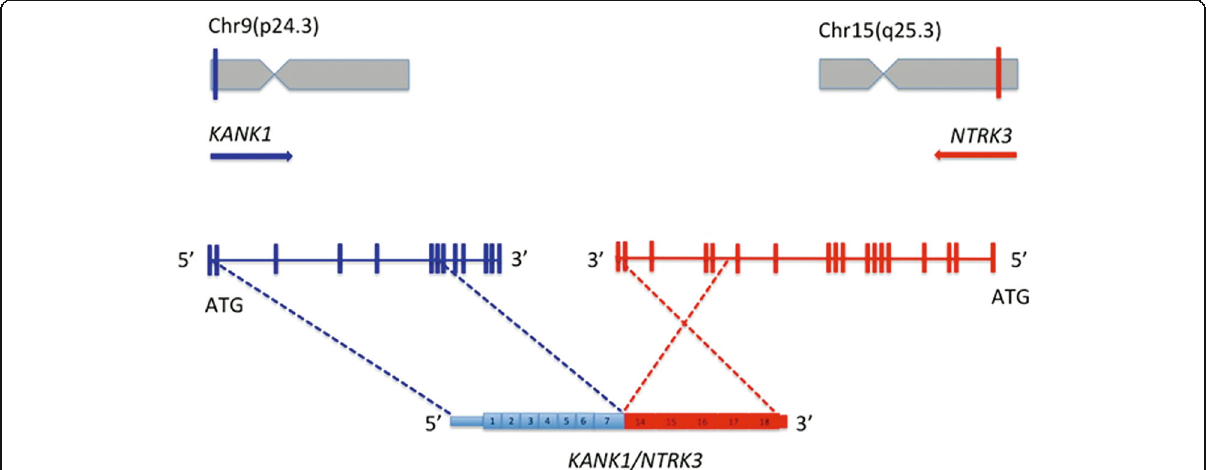
Fig. 3 Schematic diagram of genomic location of KANK1-NTRK3 fusion. Exons 1 – 7 of KANK1 are shown in blue and exons 14 – 18 of NTRK3 are shown in red